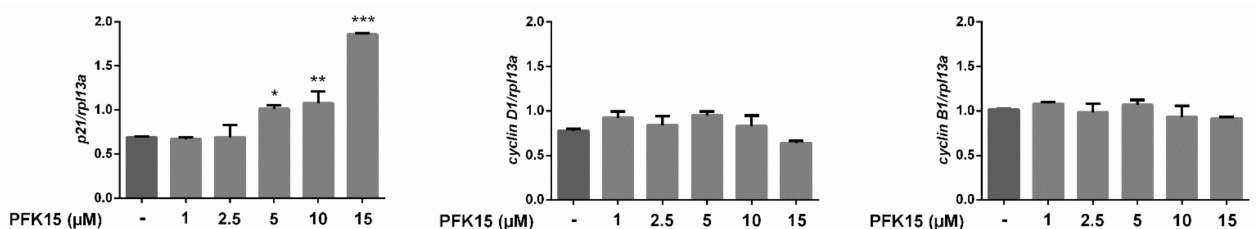
Figure 6. Effect of PFK15 on the expression of genes regulating the cell cycle in DLD1 cells. DLD1 cells were treated with PFK15 in a concentration range of 1–15 µ M for 24 h. Expression of mRNA was analyzed by real-time PCR and normalized to the level of rpl13a. Results are displayed as mean ± SEM ( n = 3). * p < 0.05, ** p < 0.01, *** p <